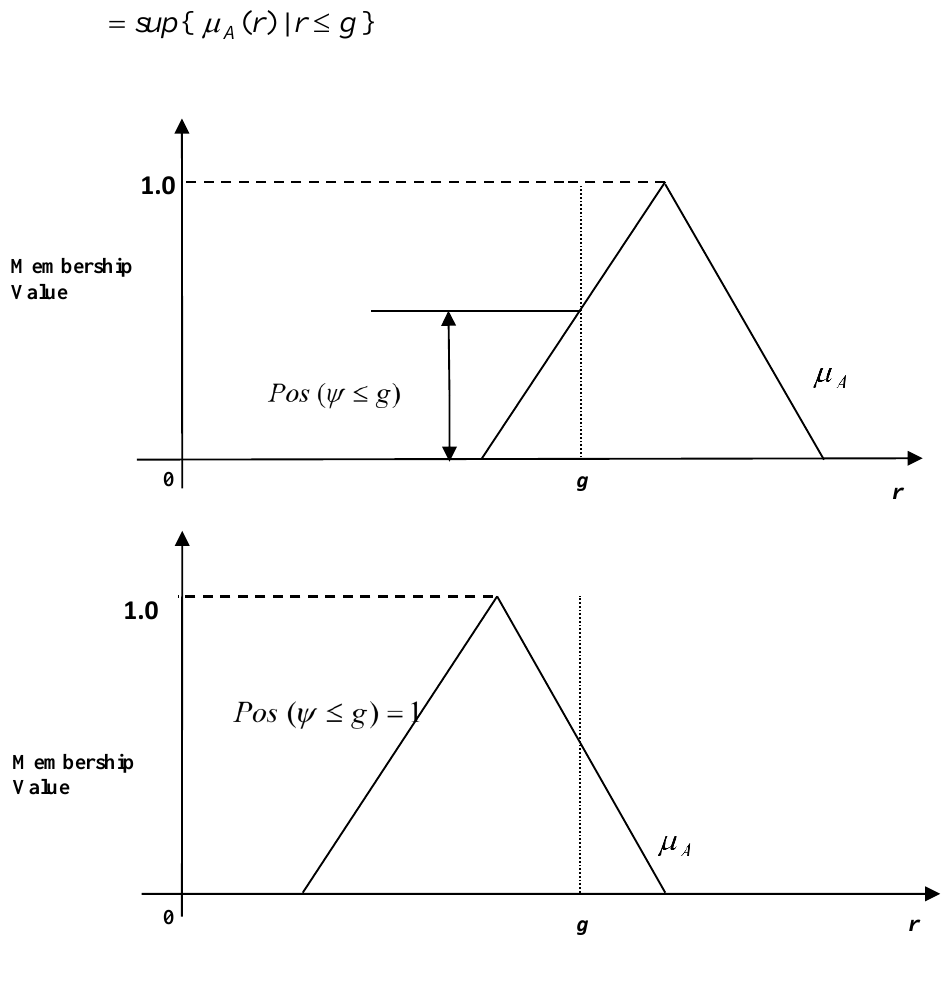
Figure 1. Possibility degree of (𝜓 ≤